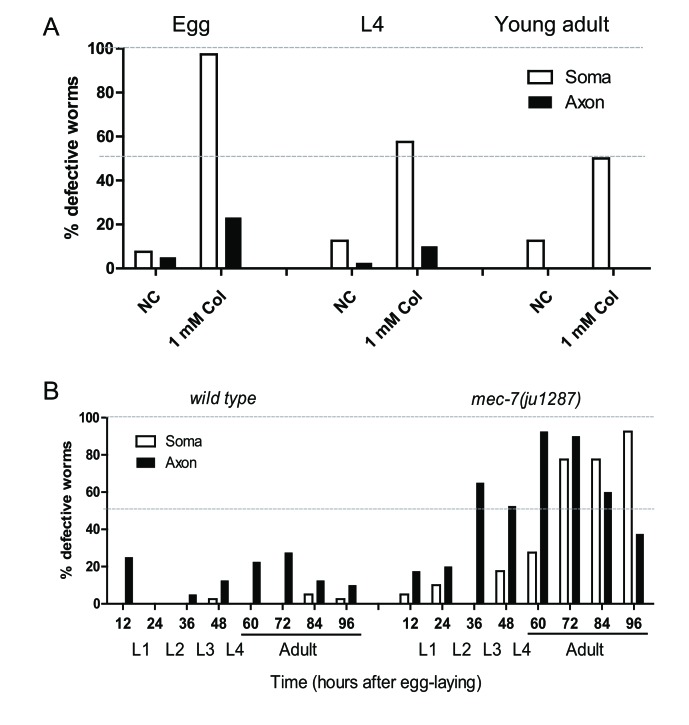
Microtubules are important for maintenance of ribosome distribution.The fraction of worms showing the ribosome distribution defects in the soma or in the axon of ALM neurons. (A) Microtubule destabilizing drug (1 mM colchicine) treatment at different stages with a negative control (NC). (B) Time course of ribosome distribution defects in the wild type or mec-7 mutants during development. The corresponding developmental stages are indicated.